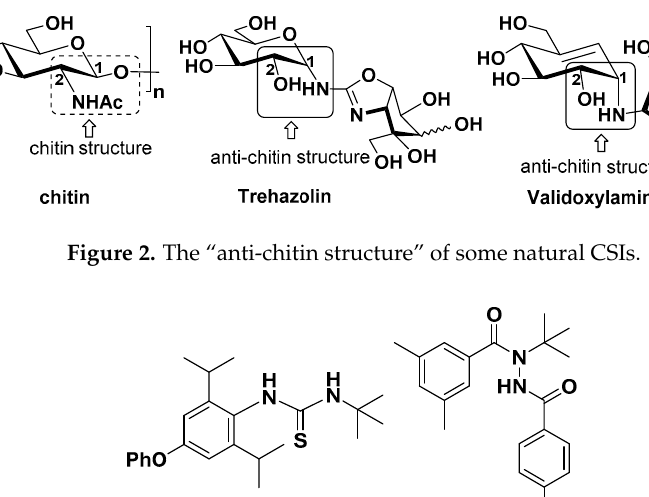
Figure 1. The structures of diflubenzuron and chitin precursor.